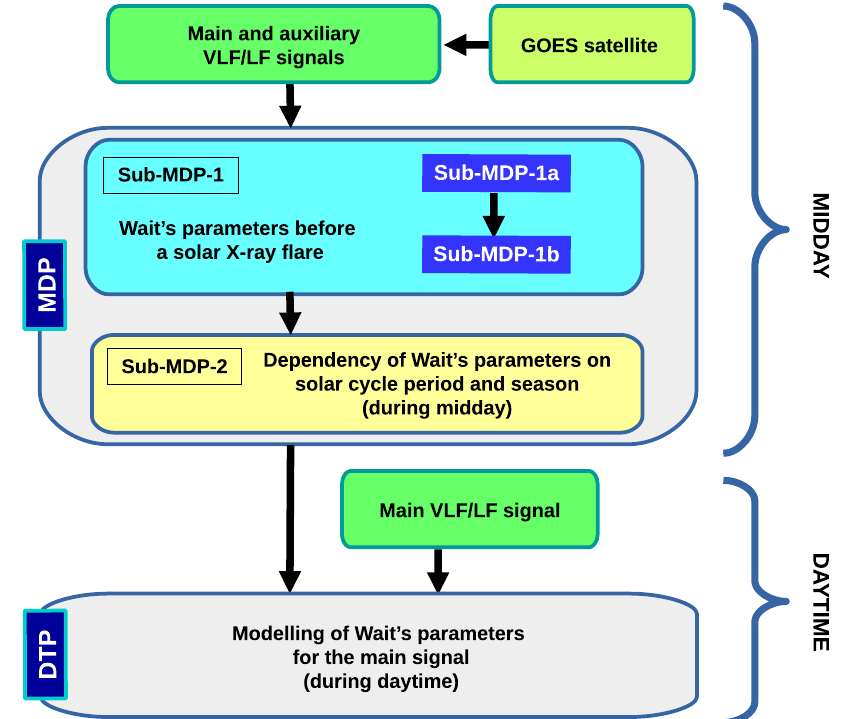
Figure 1. Diagram of the proposed methodology. It consists of two procedures, Midday procedure (MDP) and Daytime procedure (DTP), which are used for the midday and daytime periods. The VLF/LF signals and GOES data are given in input to MDP, which is split in two sub-procedures Sub-MDP-1, to estimate Wait’s parameters before a solar X-ray flare, and Sub-MDP-2 to model the dependency of these parameters on the solar cycle period and season at midday. To a finer detail, Sub-MDP-1 is further split in Sub-MDP-1a and Sub-MDP-1b, corresponding to the analyses of a signal s and a disturbed state i of an X-ray flare XF, and determination of Wait’s parameters in quiet conditions before a solar X-ray flare XF, respectively. DTP requires as input both the output of MDP and VLF/LF signals to model the daytime evolution of Wait’s